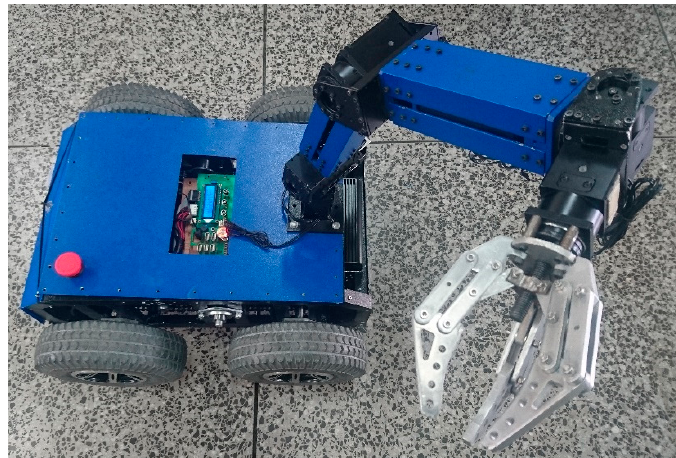
Figure 7. Mobile robotic manipulator system.